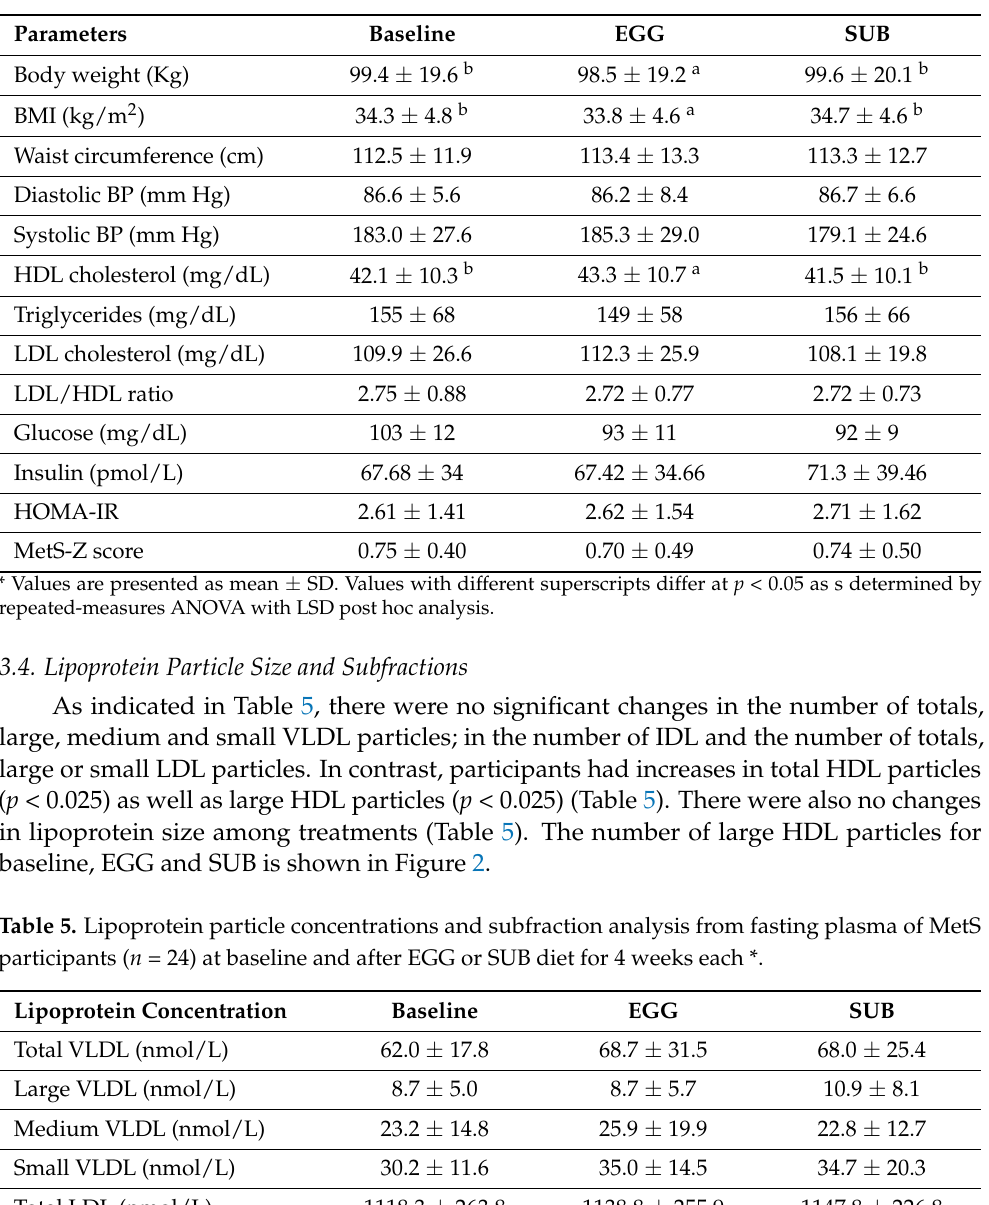
Table 4. Participant characteristics, anthropometrics, blood pressure (BP), waist circumference (WC) and plasma biomarkers of ( n = 24) MetS participants at baseline and after EGG and SUB treatments for 4 weeks each *.